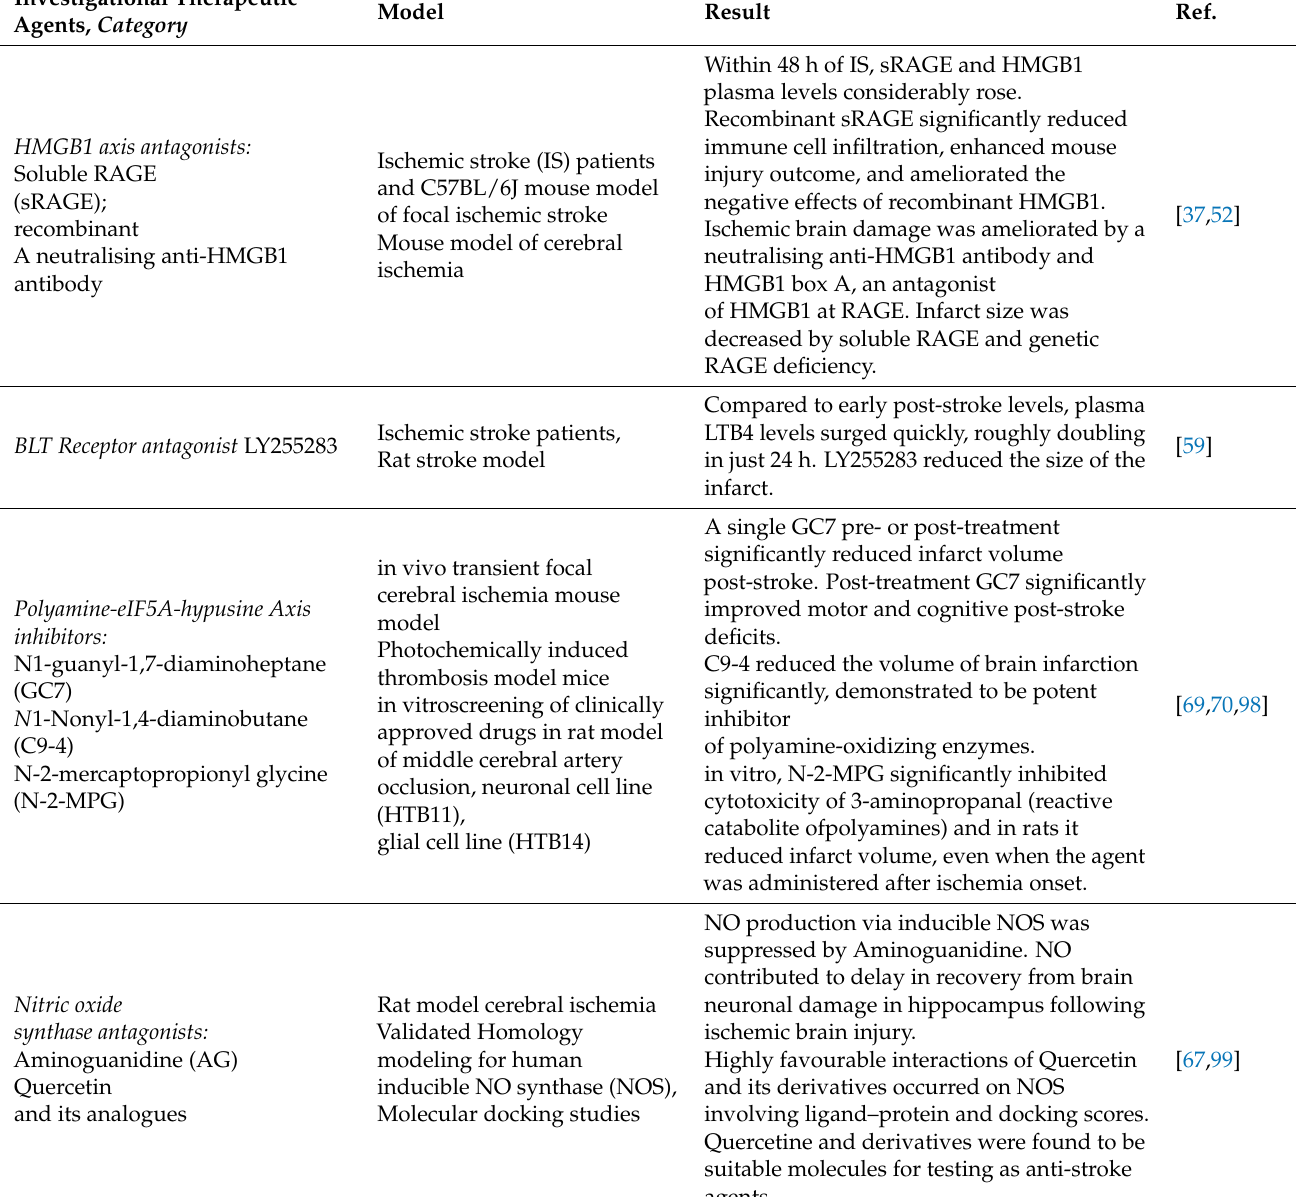
Table 6. Experimental findings on investigational/candidate therapeutic agents against targets other than AGE–RAGE Axis in ischemic